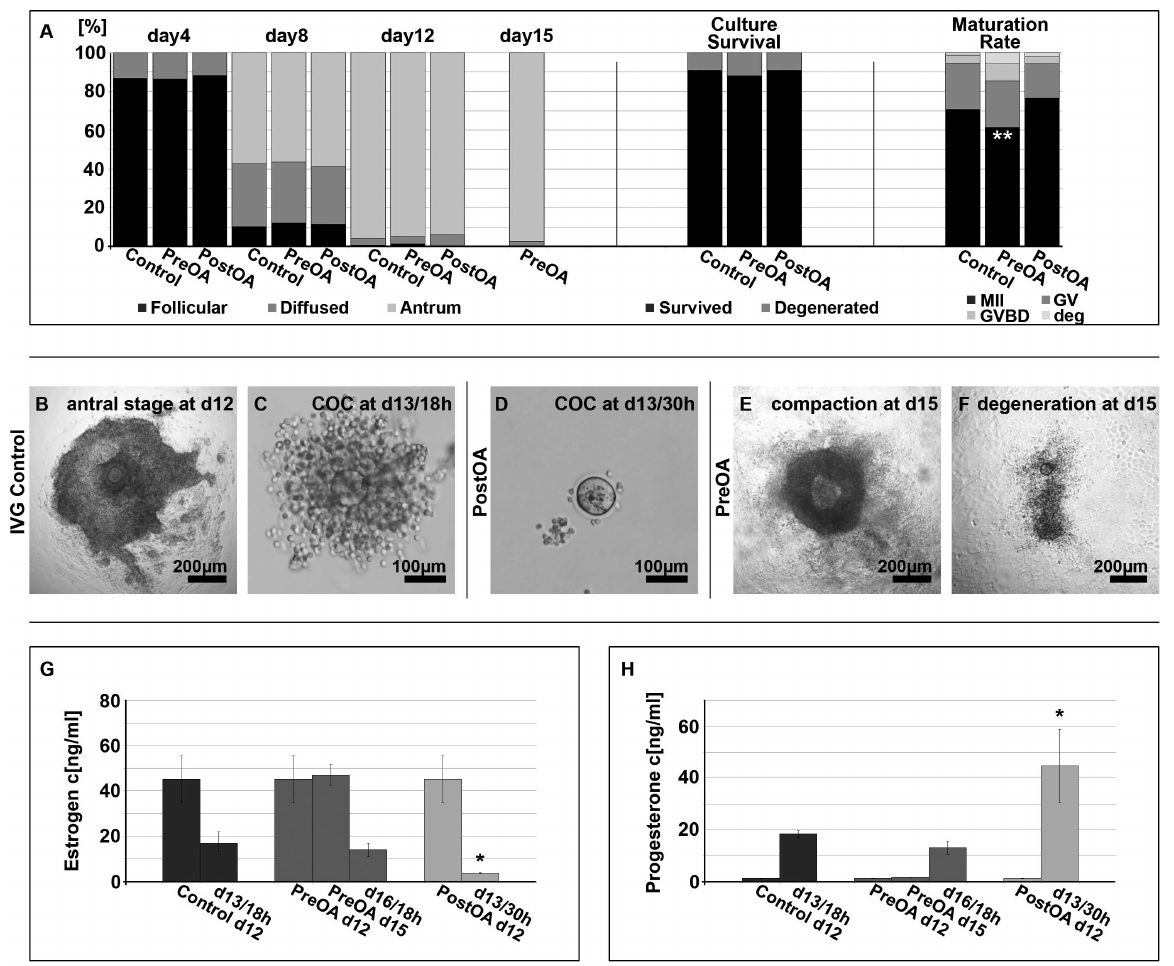
Figure 2. Follicle morphology, morphokinetics, and hormone concentrations in conditioned medium of preantral follicle culture. A) Follicle characteristics, culture survival and maturation of control ( n =1230), preovulatory-aged (PreOA; n =411) and postovulatory-aged (PostOA; n =613) oocytes. B-D) Antral stage follicle grown in vitro for 12 d (B) and cumulus-oocyte complexes on day 13 after in vitro ovulation in control oocytes (C) and after postovulatory aging (D) for 12 h. E, F) Altered granulosa cell characteristics after preovulatory aging at day 15 of culture; follicles with an increased accumulation of mural granulosa cells and an apparent follicle compaction (E), and a degenerating follicle with dispersed granulosa cells and a nearly denuded oocyte from day 15 of culture (F). G) Estrogen and (H) progesterone levels (mean 6 SEM) in conditioned culture medium prior to and past hormonal stimulation by rhCG/rEGF in the different experimental groups (* P , 0.05, ** P , 0.01).